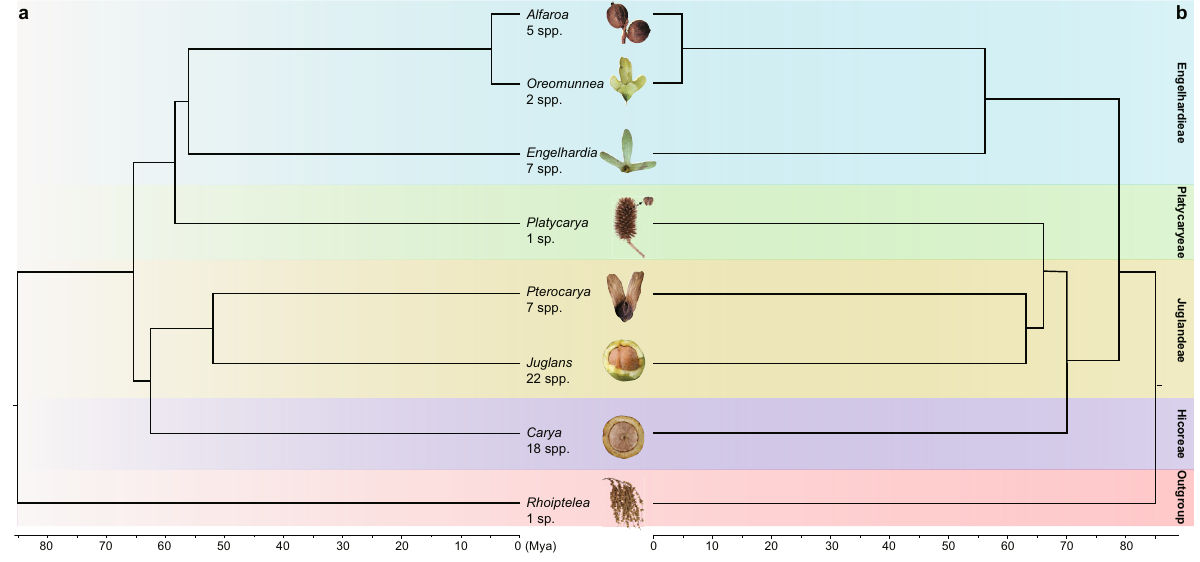
Fig.1|Morphology-basedandmolecular-basedphylogenyoftheJuglandaceae. a Phylogenetic tree modi fi ed from Wing and Hickey ’ s 20 cladistic analysisof 30leaf, fruit, in fl orescence, and pollen characters scored for extant and extinct taxa (the latter omitted here), with Rhoiptelea , Myricaceae, and Fagaceae as outgroups. For the results of four more recent morphological-cladistic analyses see main text and Supplementary Fig. 17. Cyclocarya paliurus (Batal.) Iljinsk. is here treated as